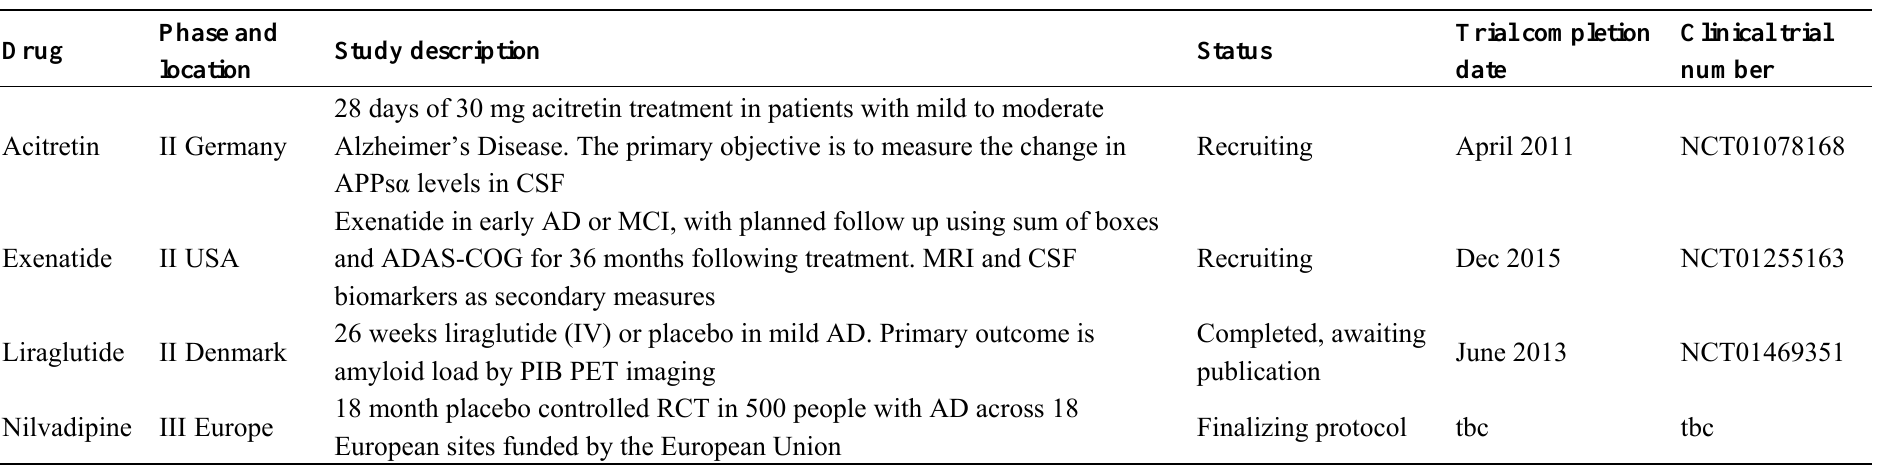
Table 2. Ongoing trials in Alzheimer’s disease related to identified candidate